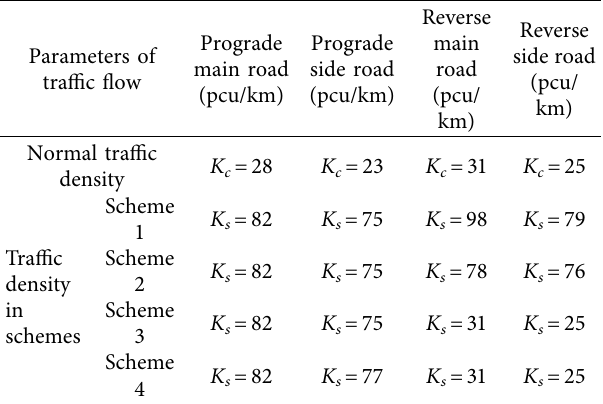
Table 2: Traffic density on East Youyi Road under different traffic control